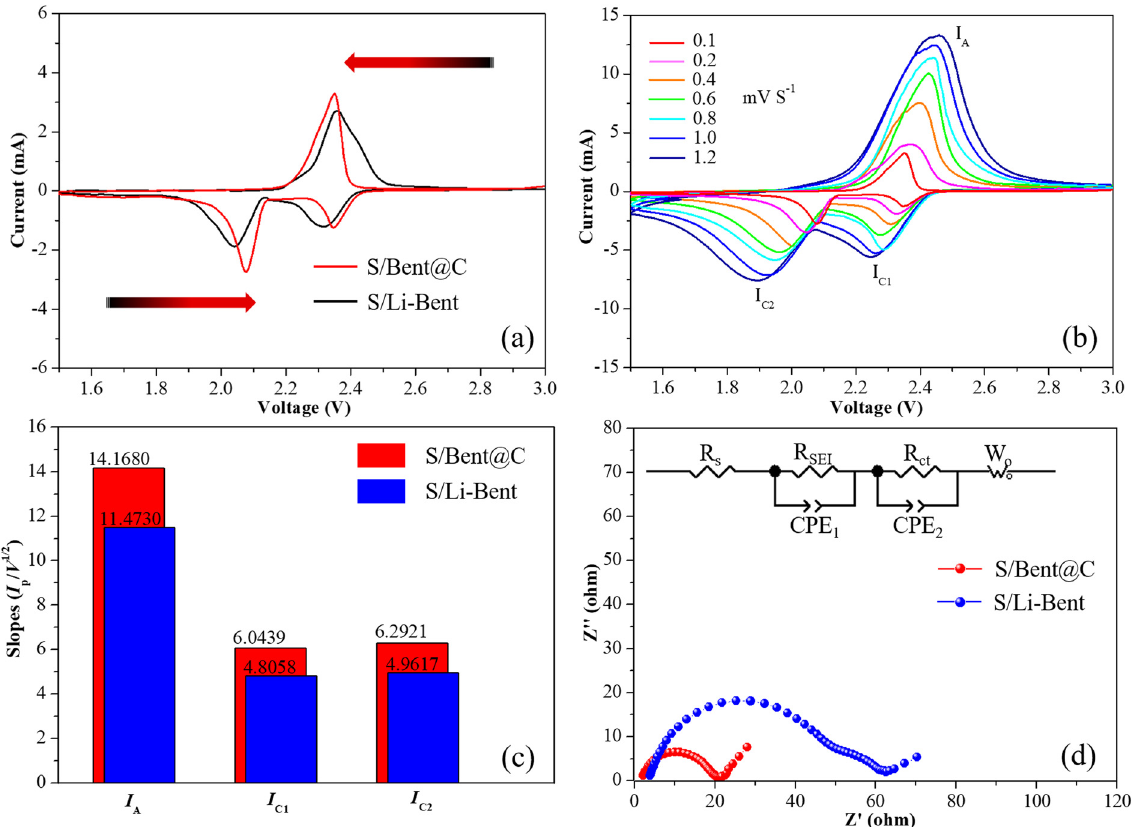
Figure 6: ( a ) CV curves of S/Bent@C and S/Li - Bent batteries at the scan rate of 0.1 mV s − 1 . ( b ) CV curves of S/Bent@C battery under di ff erent scan rates ranging from 0.1 to 1.2 mV s − 1 . ( c ) The value of I P / V 1/2 from Figure S4 that represents the lithium - ion di ff usion capability. ( d ) EIS curves and the equivalent circuit ( inset ) of S/Bent@C and S/Li - Bent